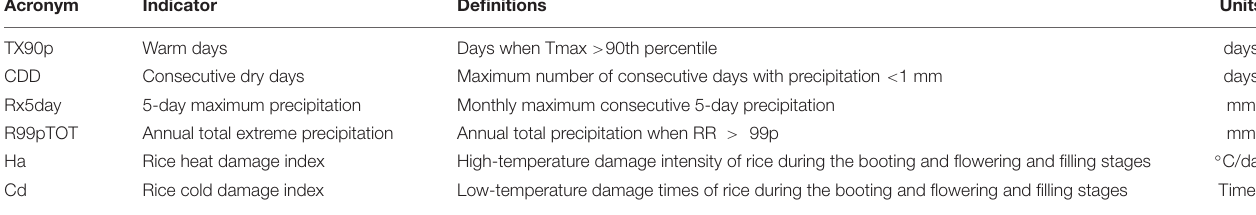
TABLE 2 | Definitions of six extreme climate indices.